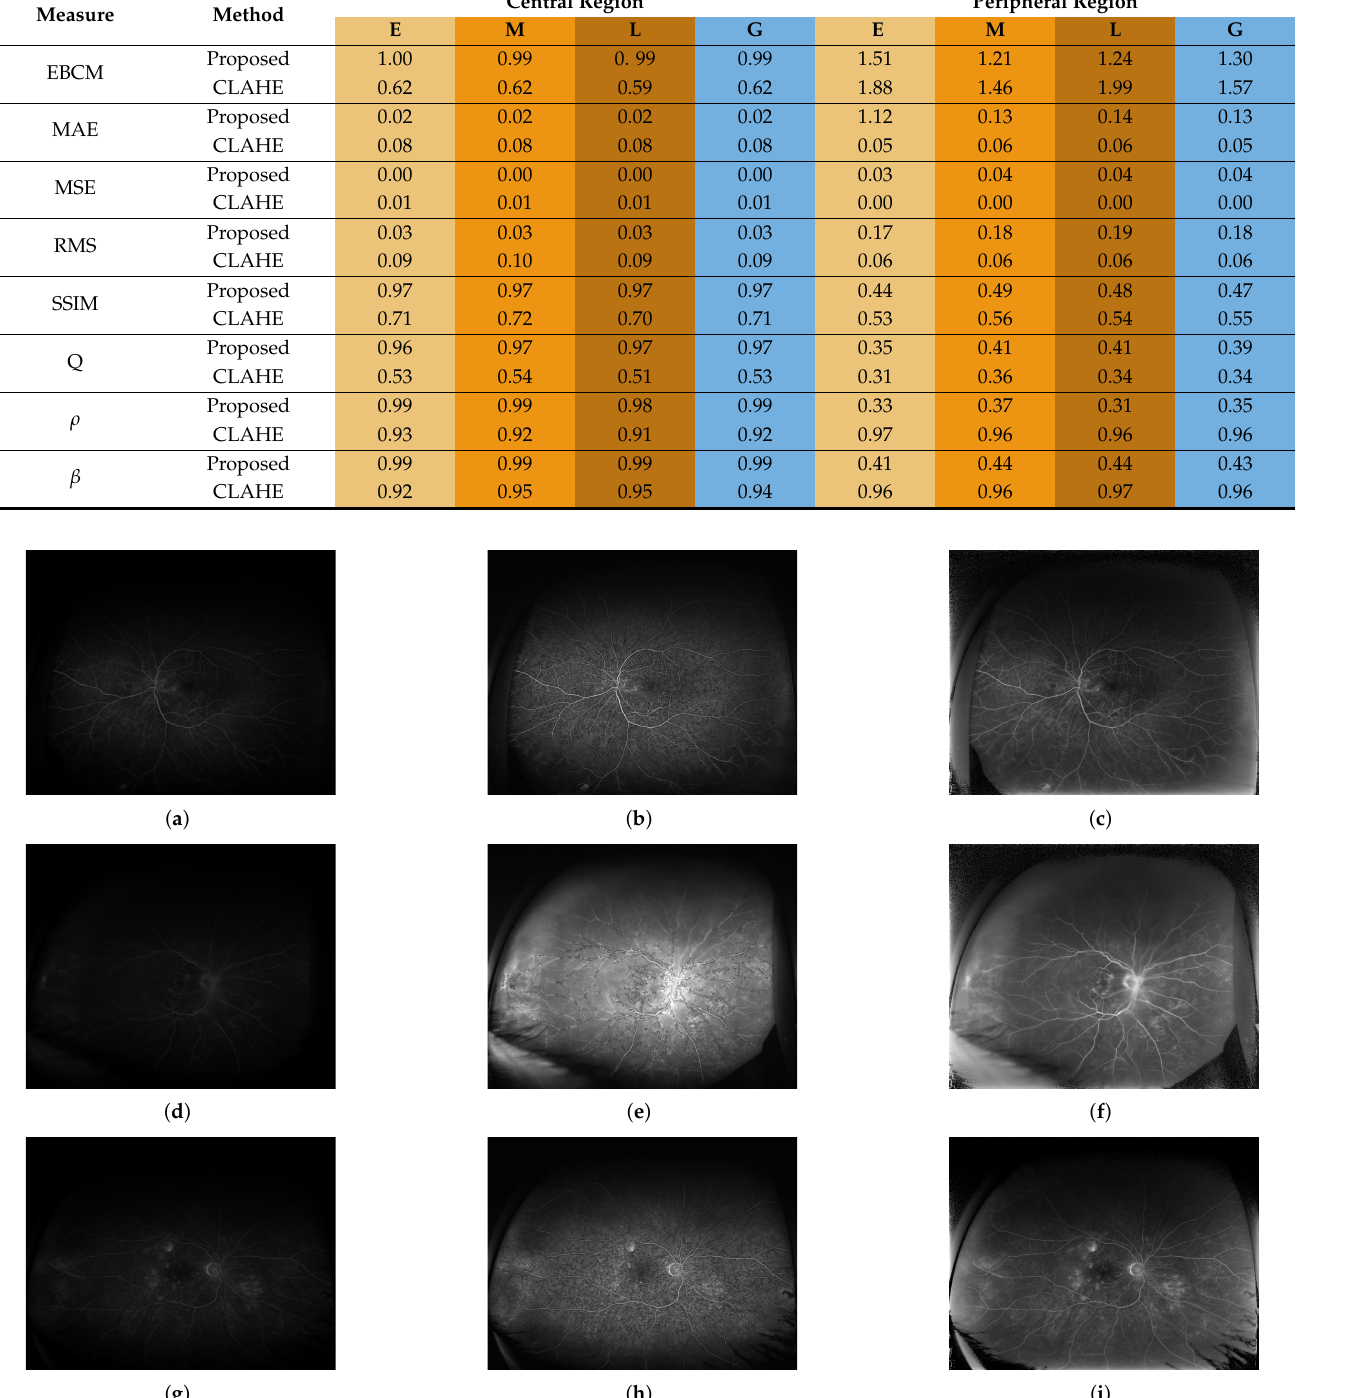
Table 3. Average values of quality measures obtained from the central and peripheral image regions for processed by the proposed and CLAHE methods.